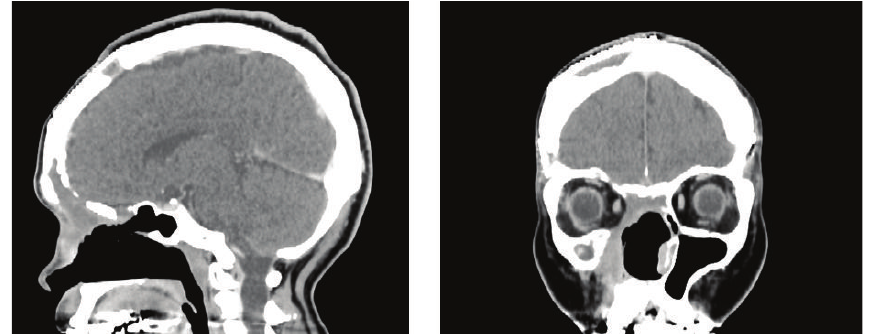
Figure 3: Postoperative computed tomography (contrast-enhanced) shows no recurrence that is seen in both nasal cavities and the intracranial